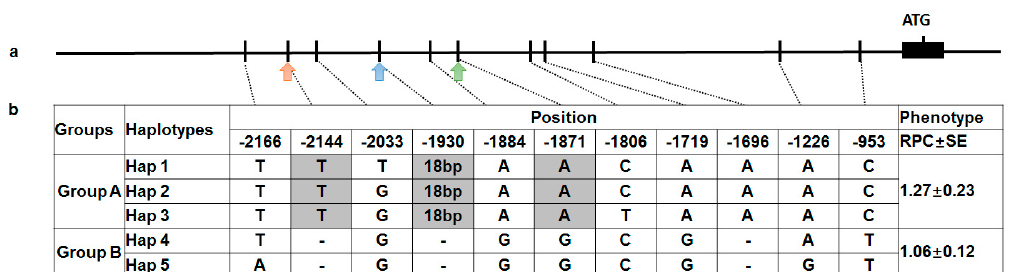
Figure 5. Candidate gene association analysis of the GmRCA β promoter region and relative P concentration in 219 soybean accessions. ( a ) The GmRCA β gene model showing the allelic variation (frequency > 5%) of the GmRCA β promoter sequence. Orange arrows indicate the TATA boxes, blue arrow indicates the AT1 motif, and green arrow indicates the ARE; ( b ) Nucleotide polymorphisms in the promoter region of GmRCA β , and two groups (Group A: Hap1, 2 and 3; Group B: Hap 4 and 5) are listed. Significant polymorphic functional nucleotide sites are indicated in gray. The haplotype effects were estimated based on the mean relative P concentration (RPC). RPC: relative P concentration under optimum P and − P.